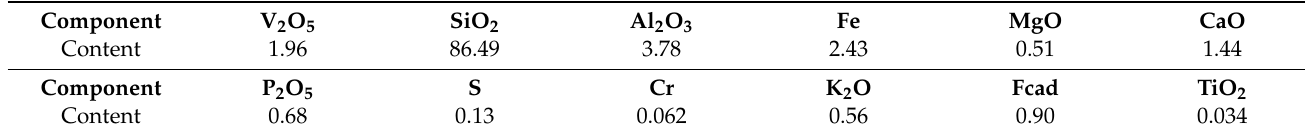
Table 4. Main chemical multi-element analysis of original samples/%.